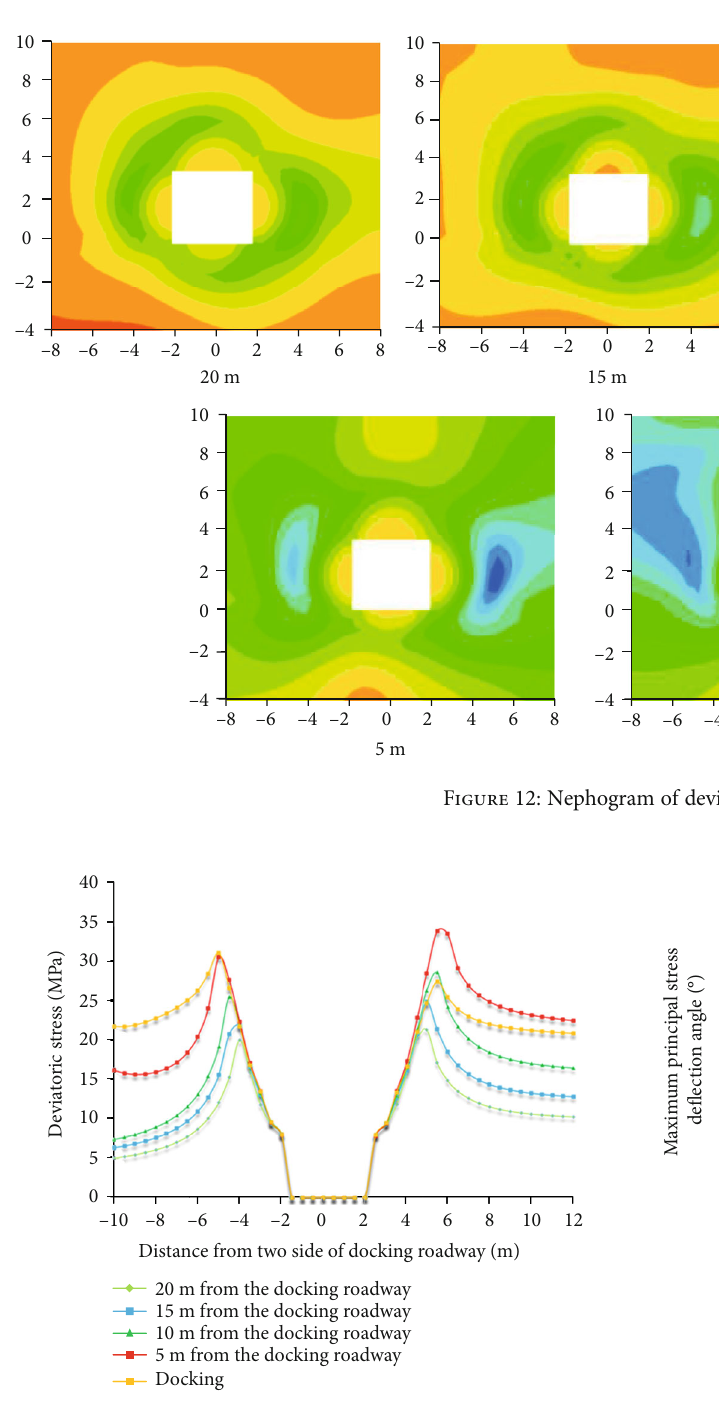
14: Variation diagram of the de fl ection angle of maximum principal stress of two